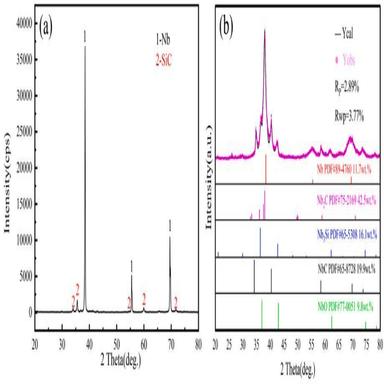
XRD patterns of the Nb–SiC composite powder and niobium carbide composite coating: (a) Nb–SiC composite powder, (b) niobium carbide composite coating.